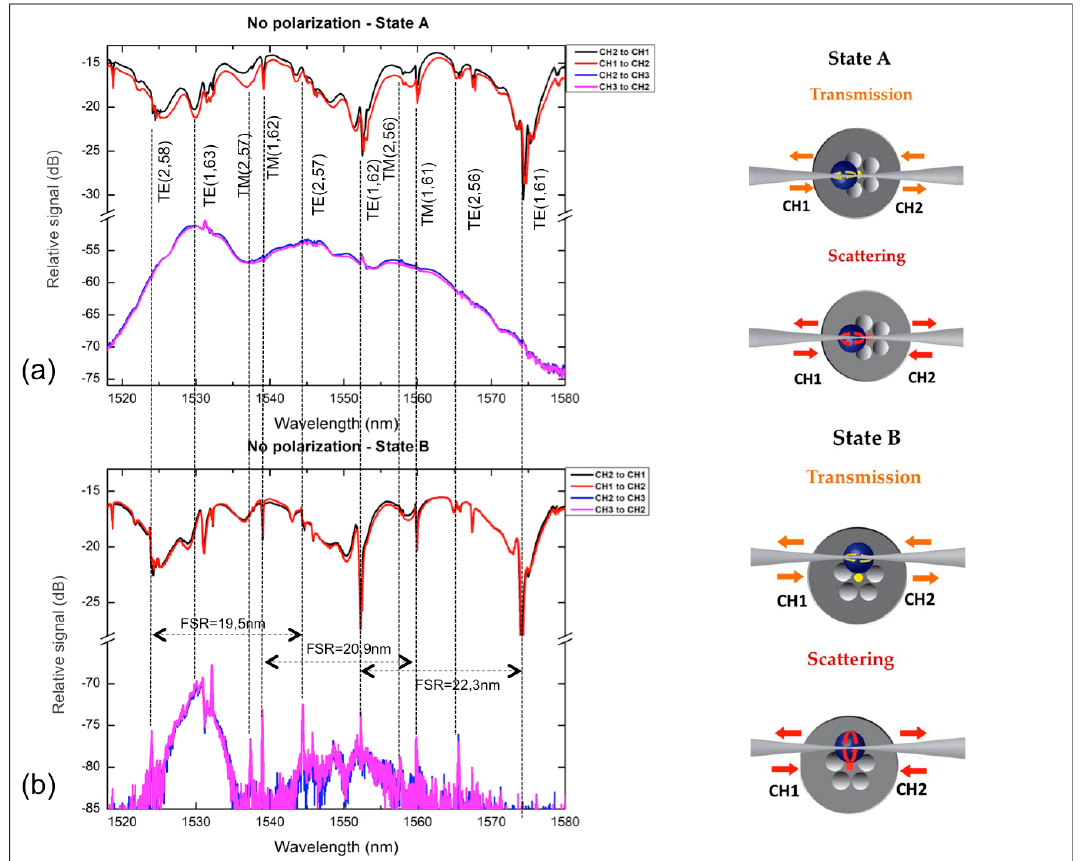
Figure 4. Both states A and B for transmission and scattering are measured and plotted at first with an SMF28 without using polarizing optical fiber. The coupling between the SOFT and the core of the MOF taper in State A ( a ) is obvious by observing the elimination of clear and sharp resonances whereas the geometry of State B ( b ) allows us to obtain more significant resonances in the scattering spectra.